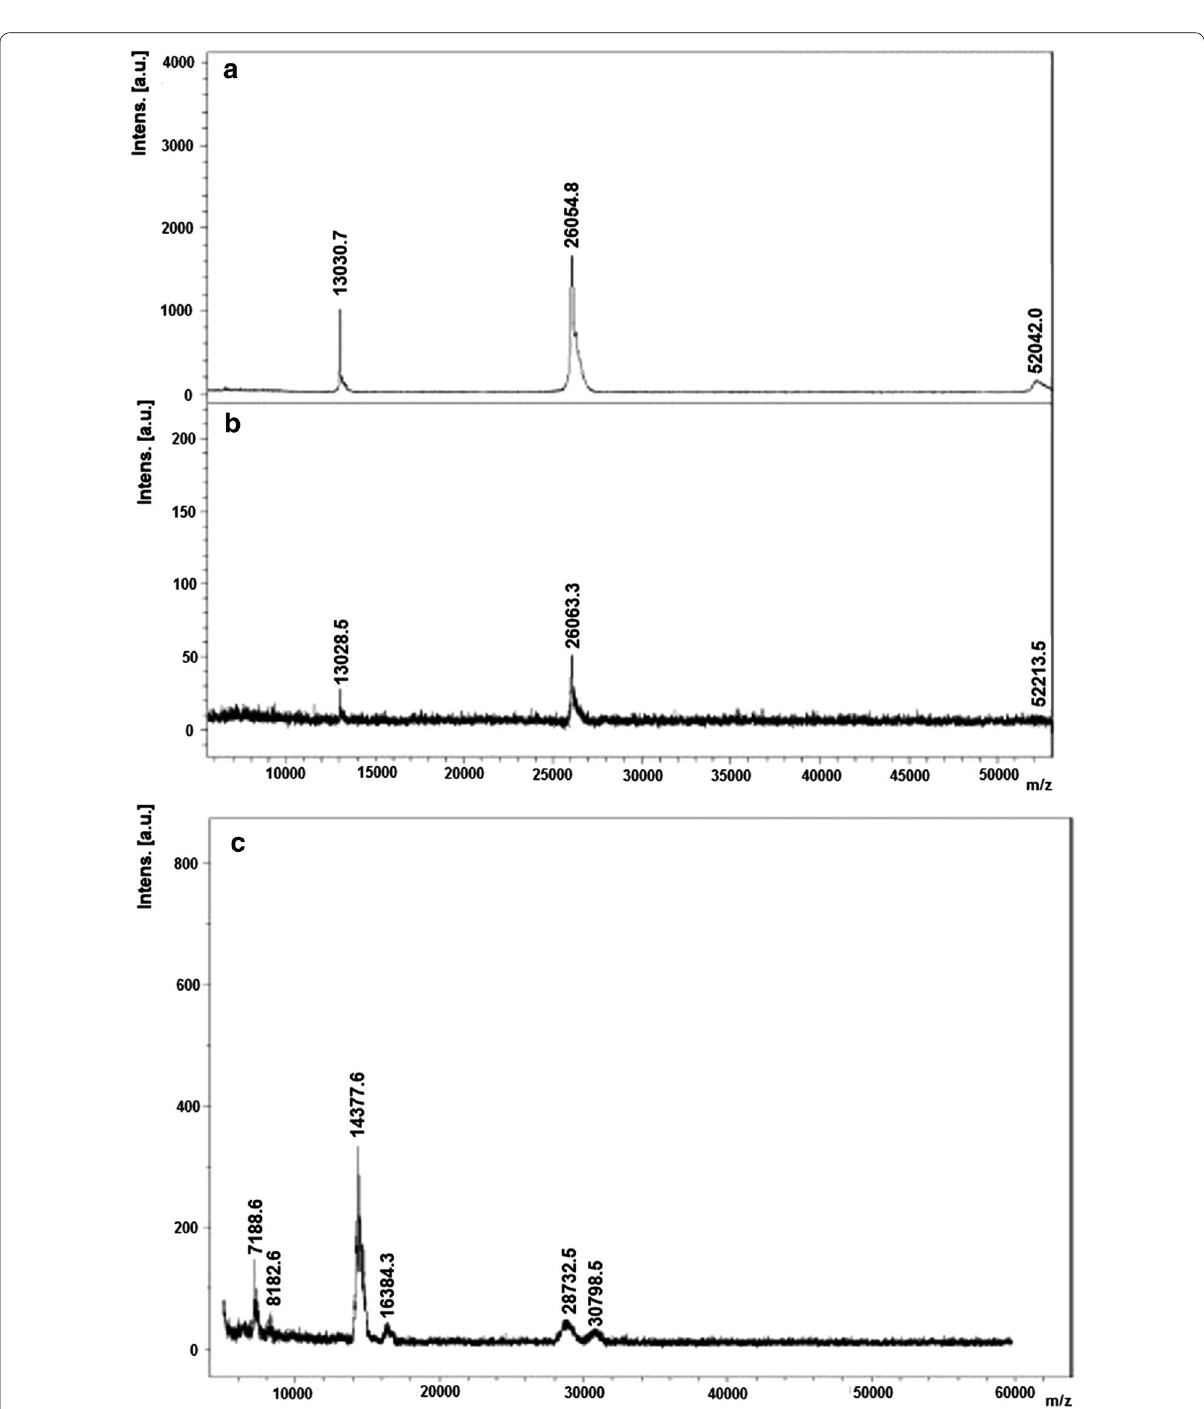
Fig. 5 MALDI-TOF-MS for exact molecular mass (MM) determination of: a E. coli -derived met-hBMP-2 from GenScript (theoretical MM lyophilized after extensive dialysis against 50 mM acetic acid; b same as in “ a ”, reconstituted with 20 mM acetic acid as recommended; c CHO-derived hBMP-2 (Infuse ®